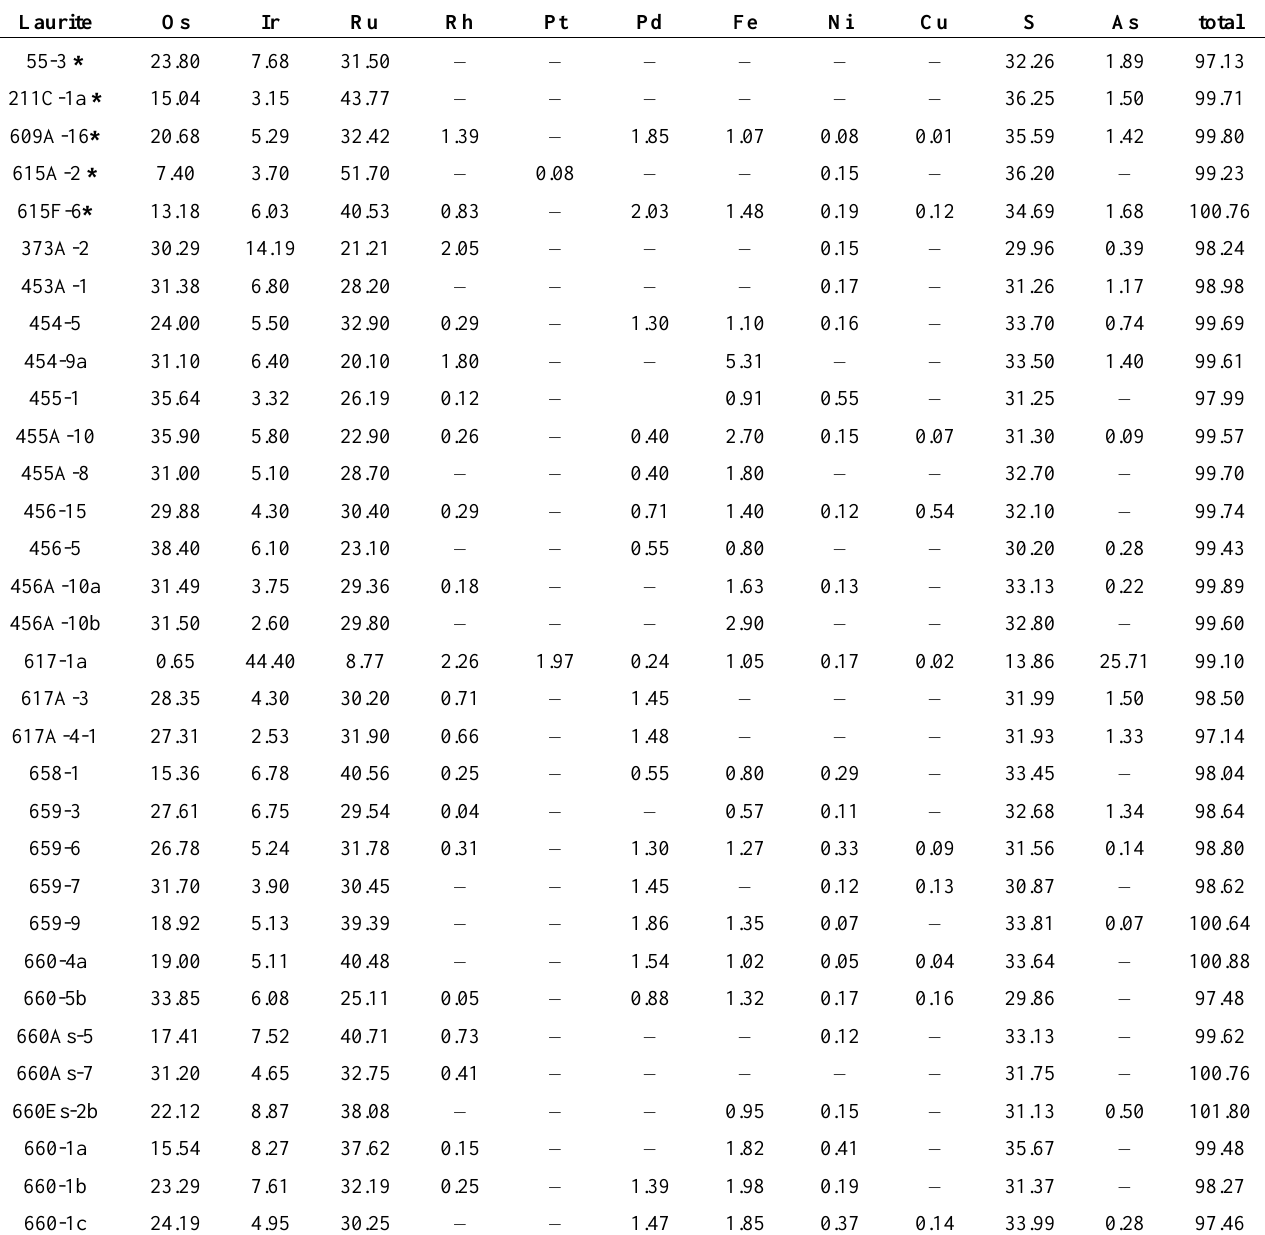
Table 2. Electron microprobe analyses of laurite and erlichmanite from